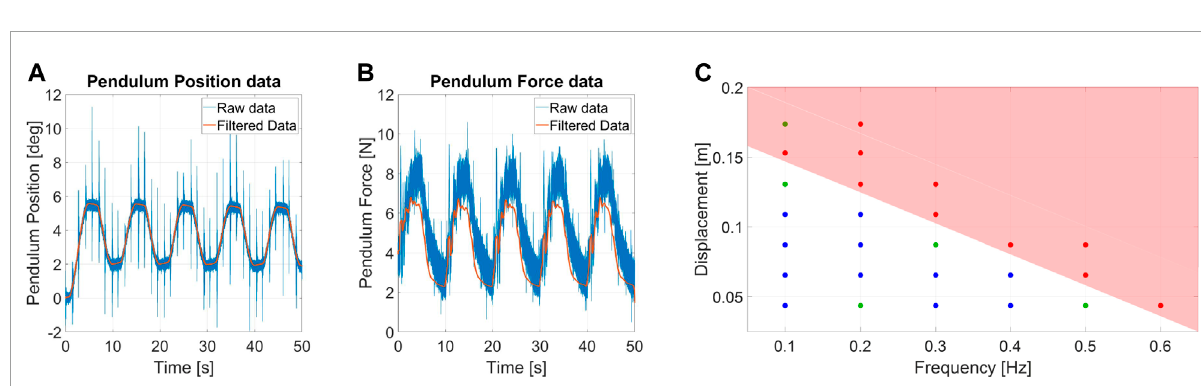
ERreveals a low-frequency force range which is more destabilizing for Alter-Ego. Its dynamics act as a low pass filter, better rejecting high-frequency perturbations. In case of repetitive displacement perturbations, the pendulum